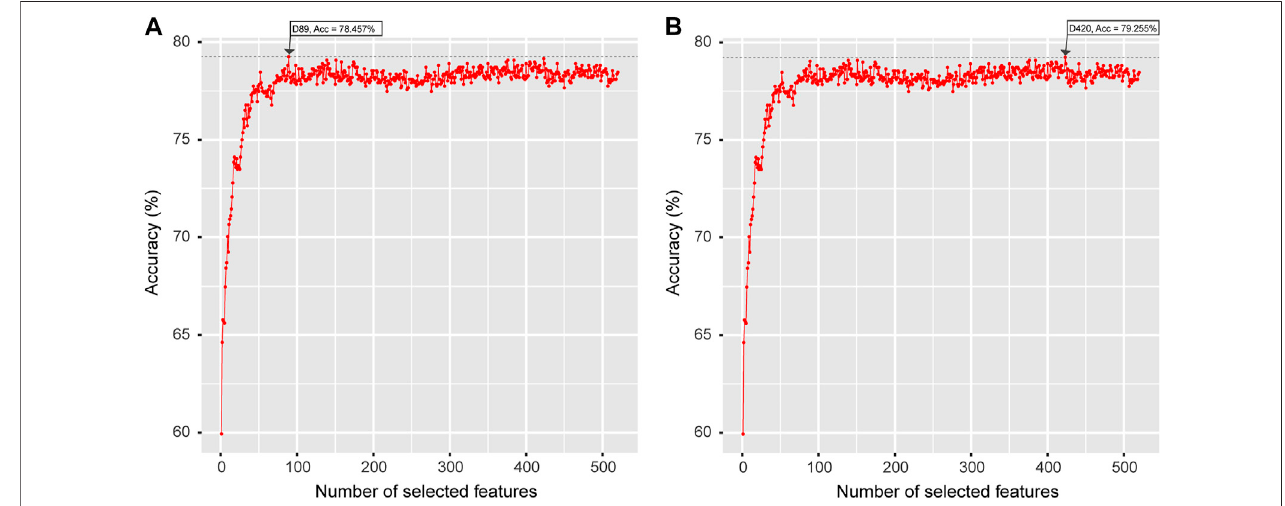
FIGURE 4 | The optimal feature sets selected by LGBM feature importance ranking (A) and a well-established MRMD strategy (B) . The horizontal axis represents the number of selected features, and the vertical axis represents the accuracy value calculated by the LGBM classi fi er.